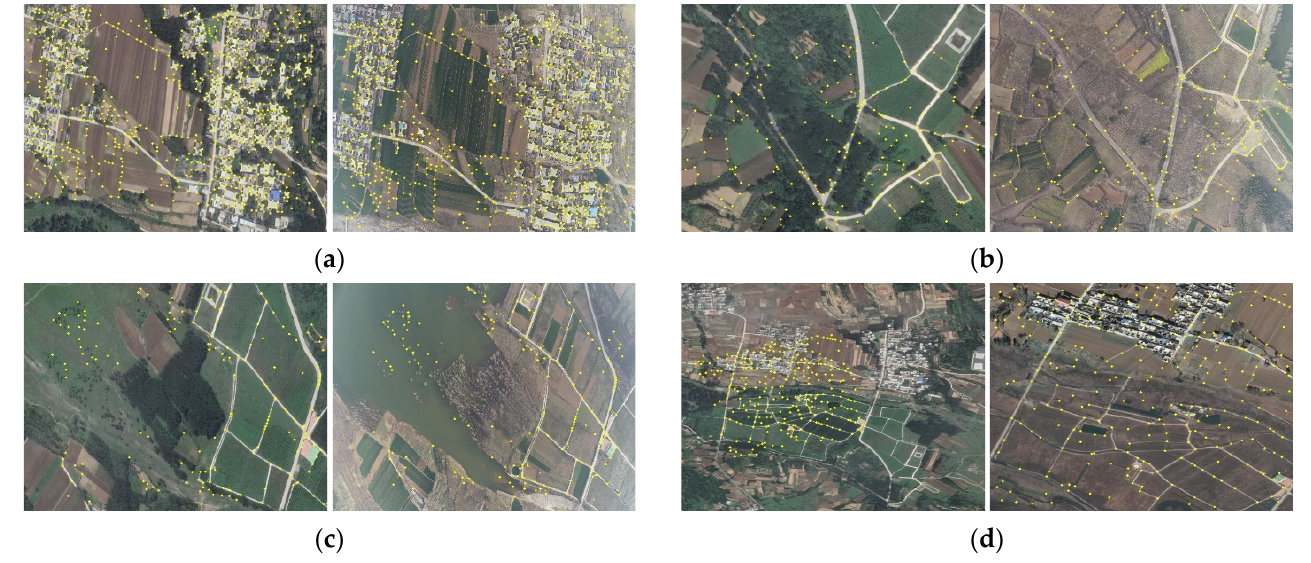
Figure 6. Initial matches found by SuperGlue: ( a ) image pair a, ( b ) image pair b, ( c ) image pair c, and ( d ) image pair d. Note: the yellow dots are the initial matches found by SuperGlue.